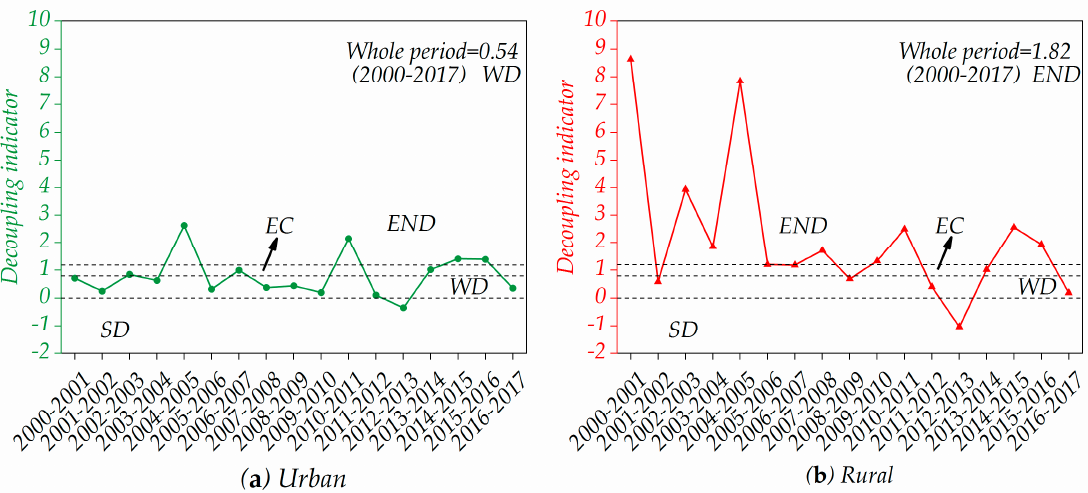
Figure 5. Decoupling states in Guangdong urban and rural regions during 2000–2017. ( a ) Urban. ( b ) Rural.